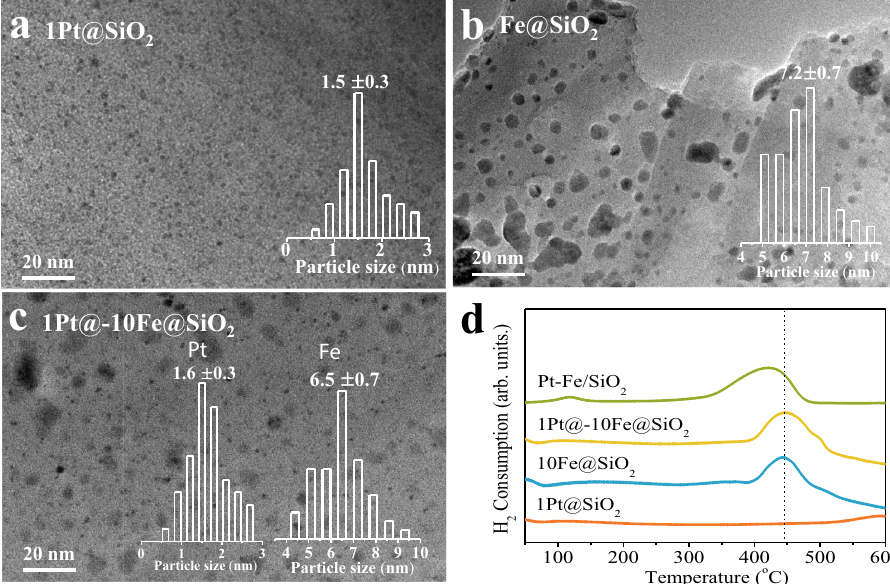
Fig. 2 Structural characterization of Pt@-Fe@SiO 2 catalysts. TEM images for ( a ) 1Pt@SiO 2 ; ( b ) 10Fe@SiO 2 , and ( c ) 1Pt@-10Fe@SiO 2 ; ( d ) H 2 -TPR pro fi les for the oxide precursors of these samples with a Pt-Fe/SiO 2 catalyst (1 wt% Pt, 10 wt% Fe) synthesized via a co-impregnation method as reference.